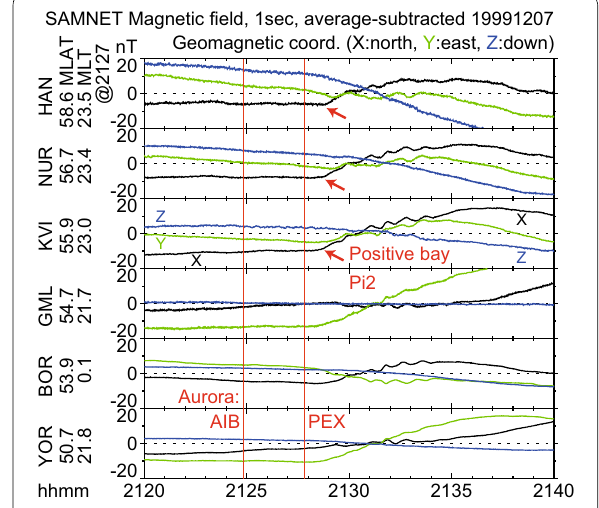
Fig. 10 SAMNET ground magnetic observations near the substorm onset longitude below 60 MLAT. The format is the same as that of the IMAGE magnetic observations in Fig. 9a, except that the 1-s values are shown and the average of the displayed interval was subtracted for each observatory. Pi2 and positive bay began at 2128:50